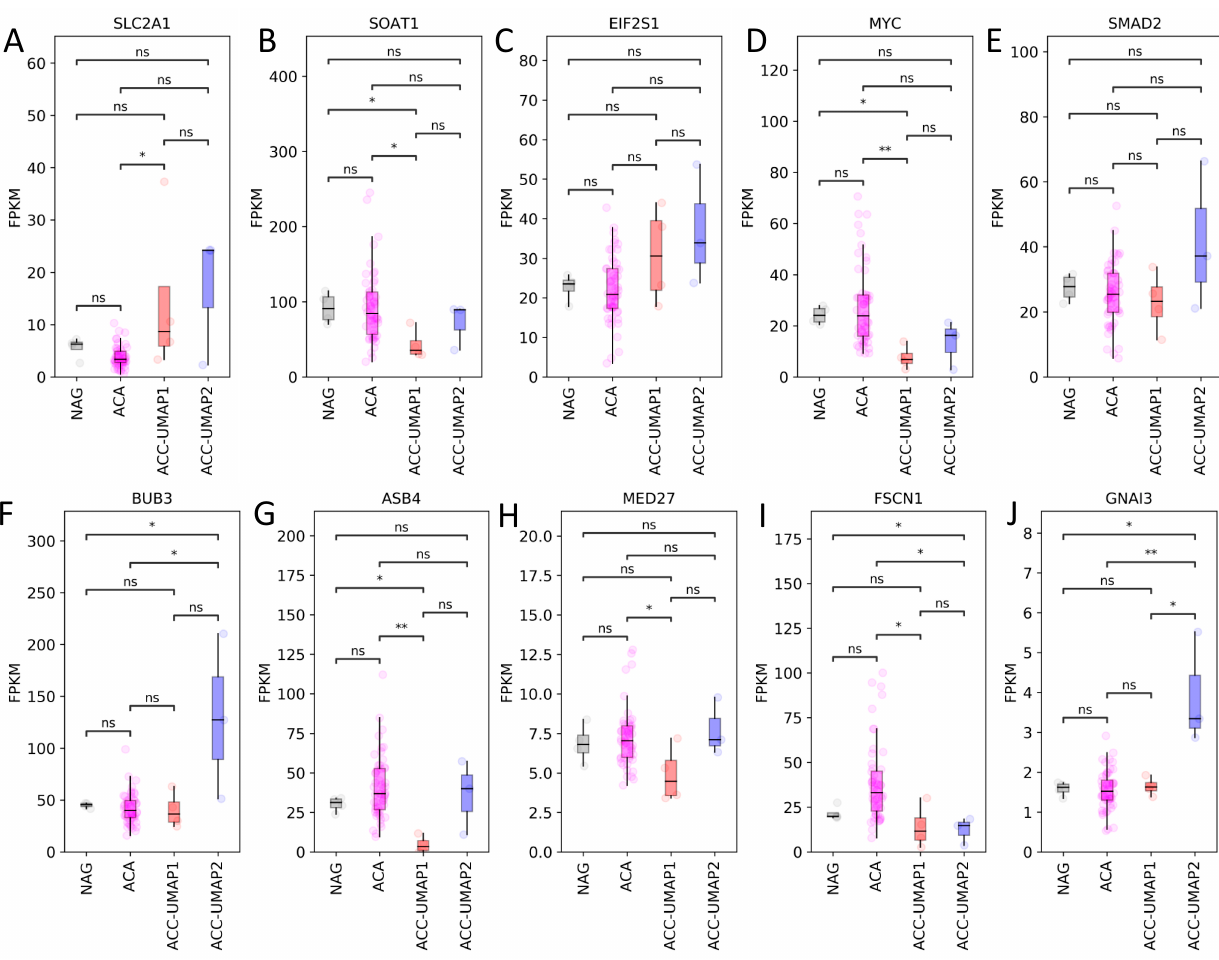
Figure 3. Selection of mRNA expression pattern of 10 genes from the validation dataset, as identified by RF analysis, that were previously shown to be involved in adrenal function. SLC2A1: solute carrier family 2 member 1 ( A ) , SOAT1: sterol-O acyltransferase ( B ), EIF2S1: eukaryotic translation initiation factor 2 α ( C ), MYC: proto-oncogene MYC ( D ), SMAD2: sma—and mad-related protein 2 ( E ), BUB3: budding uninhibited by benzimidazoles 3 homolog ( F ), ASB4: ankyrin repeat and SOCS box containing 4 ( G ), MED27: mediator complex subunit 27 ( H ), FSCN1: fascin actin-bundling protein 1 ( I ), GNAI3: guanine nucleotide binding protein (G protein), alpha inhibiting activity polypeptide 3 ( J ) . NAG = normal adrenal gland; ACA = adrenocortical adenoma; ACC = adrenocortical carcinoma. ns, not significant. * p < 0.05, ** p < 0.01, ns, not significant. Y -axis units: FPKM.